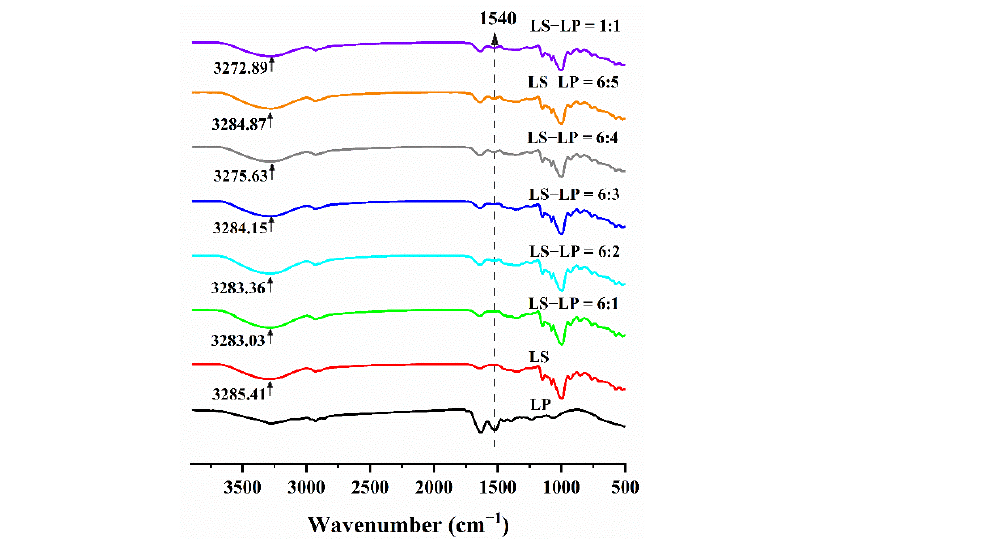
Figure 1. Infrared absorption spectra of lotus seed starch–protein mixture. Note: The figure displayed that lotus seed starch–protein mixture (LS-LP). LS indicates lotus seed starch. LP indicates lotus seed protein. LS-LP = 6:1–5 or 1:1 indicates lotus seed starch–protein with different ratios.